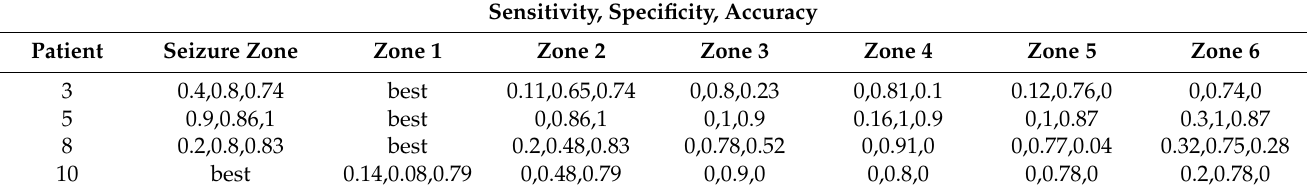
Table 3. This shows the mean second-best results for sensitivity, specificity and accuracy, respectively, in each zone over all values of ρ and σ